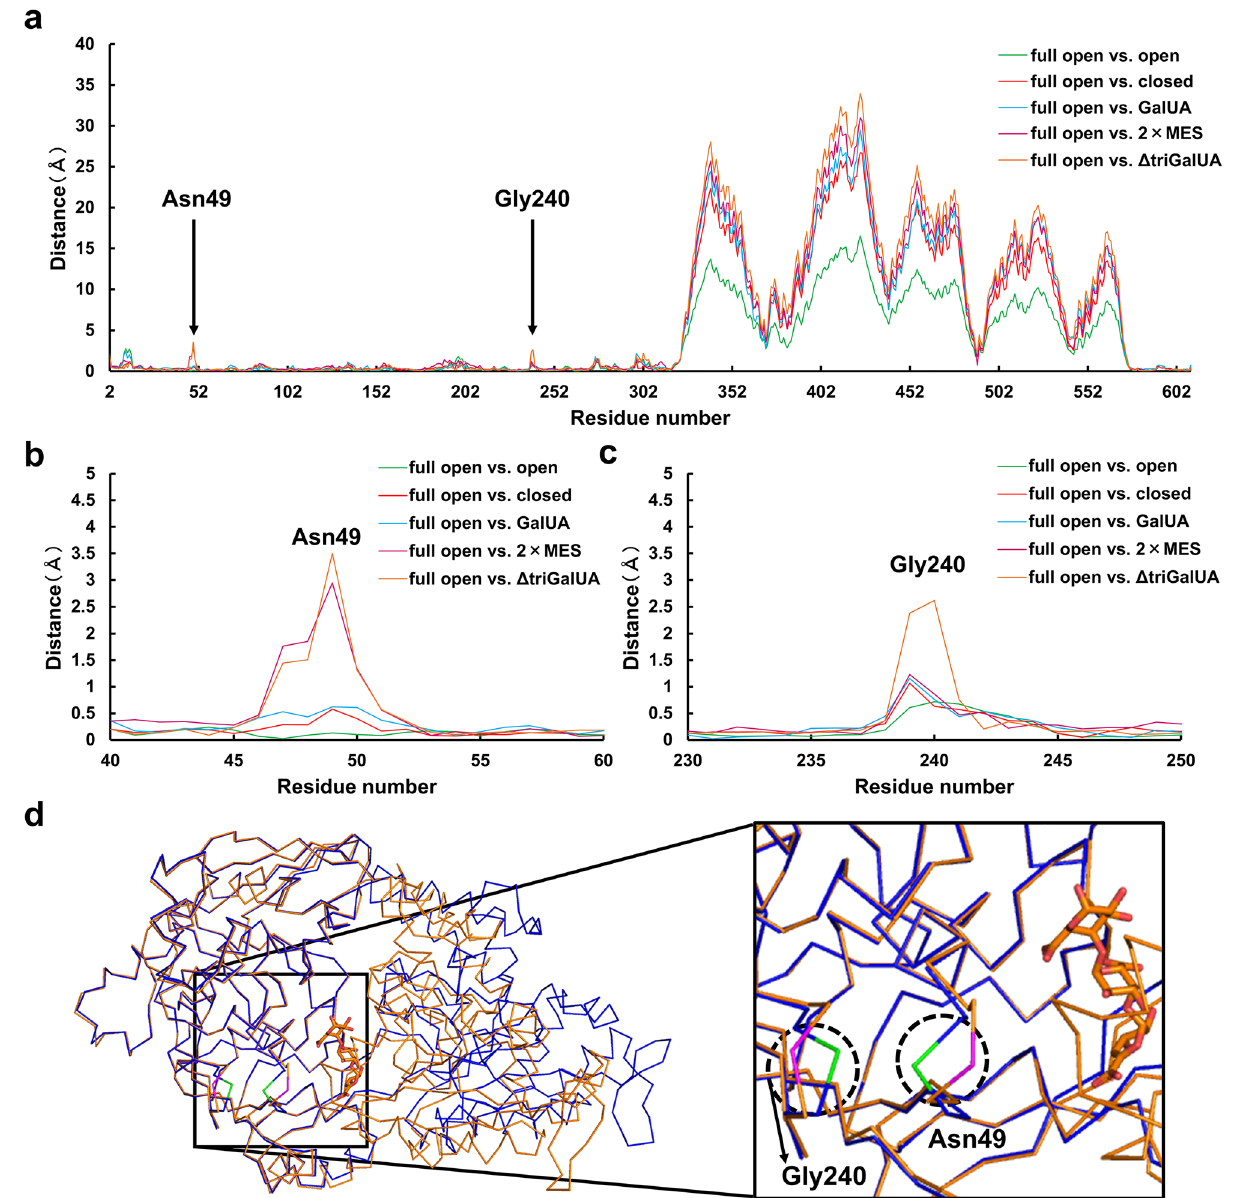
Figure 5. Conformational change in each residue of SPH1118. ( a ) Distance of the Cα at each residue (2–610) relative to that of SPH1118 (full open form) in the superimposed structure at N terminal domain. Green, SPH1118 (open form) vs. SPH1118 (full open form); red, SPH1118 (closed form) vs. SPH1118 (full open form); cyan, SPH1118/GalUA vs. SPH1118 (full open form); magenta, SPH1118/2 × MES vs. SPH1118 (full open form); orange, SPH1118/ΔtriGalUA vs. SPH1118 (full open form). ( b ) Distance of the Cα at each residue (40– 60) relative to SPH1118 (full open form). ( c ) Distance of the Cα at each residue (230–250) relative to SPH1118 (full open form). ( d ) Local conformational changes in SPH1118. Ribbon and stick models show the main chain of SPH1118 and ΔtriGalUA, respectively. Blue, SPH1118 (full open form); orange, SPH1118/ΔtriGalUA; green, Asn49 and Gly240 in SPH1118 (full open form): magenta, Asn49 and Gly240 in